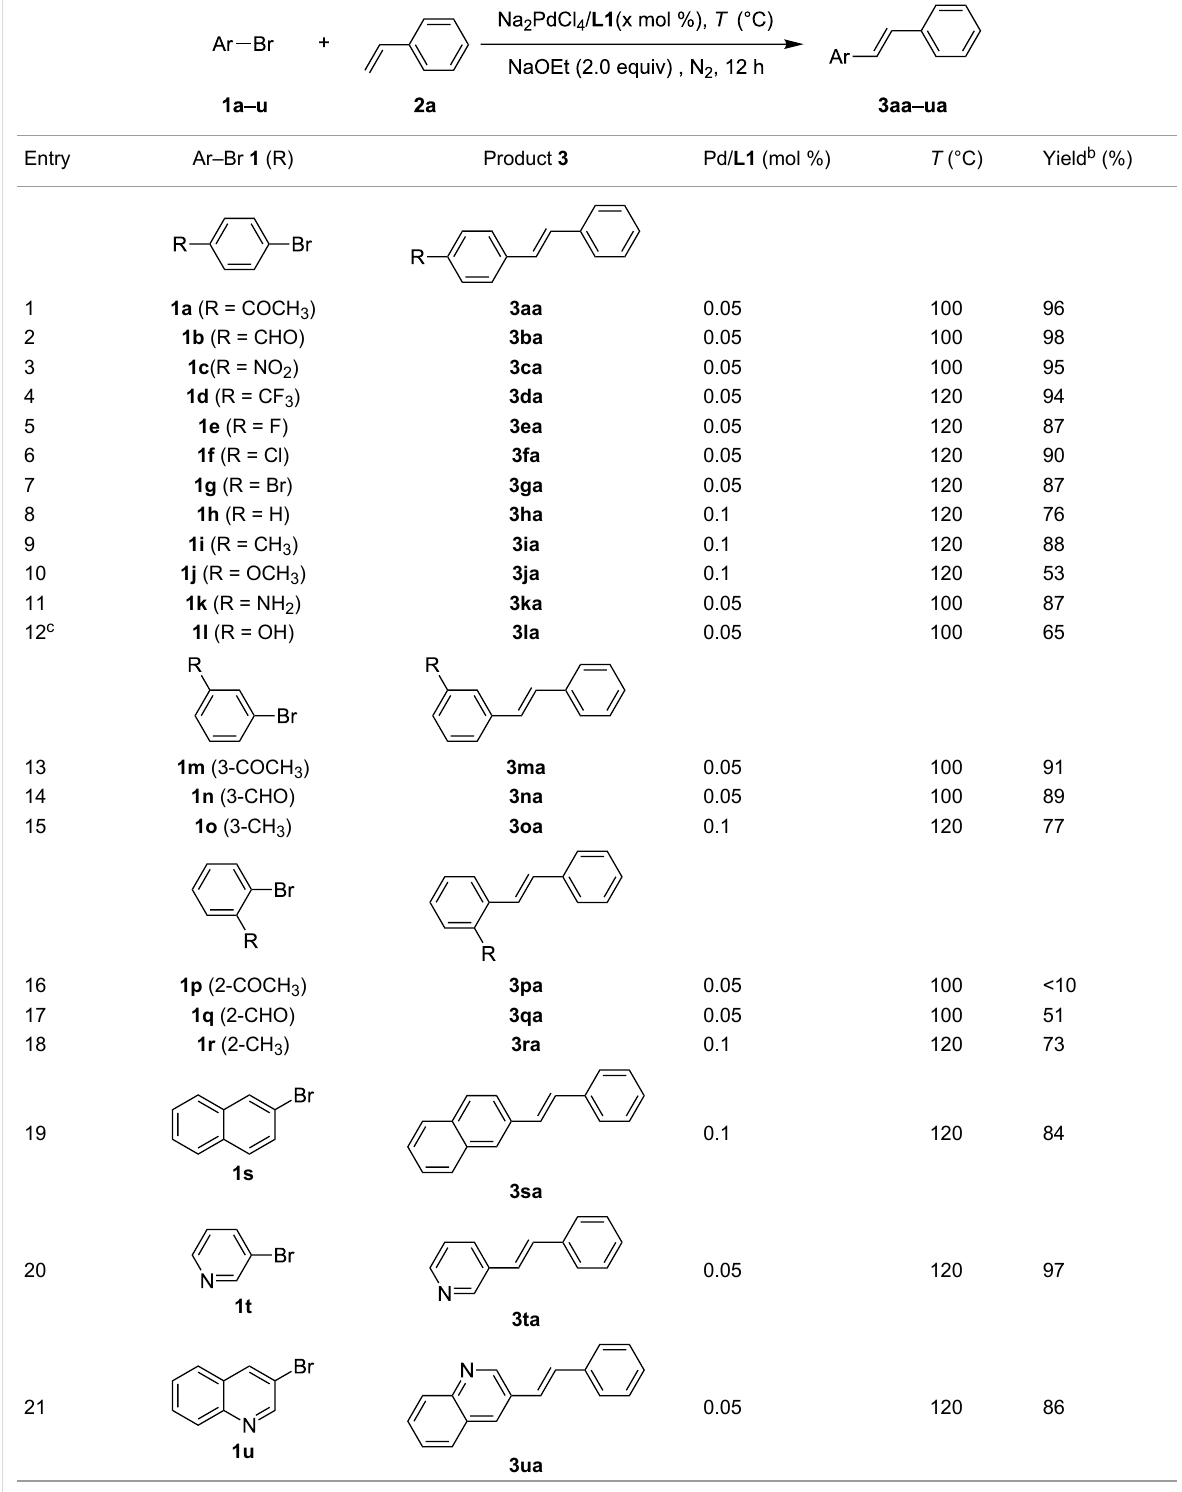
Table 2: Mizoroki–Heck reactions between substituted aryl bromides and styrene.